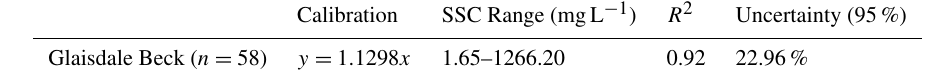
Table 1. Summary statistics of the turbidity probe field calibrations. The relationship is significant at the 99.9% level.